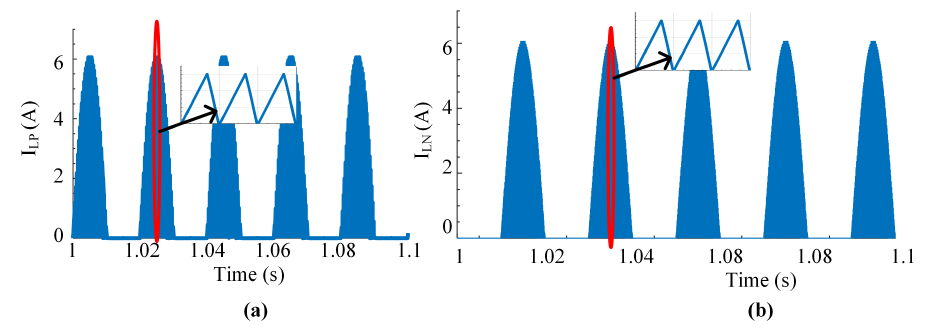
Figure 9. ( a ) Current through inductor L P . ( b ) Current through inductor L N .